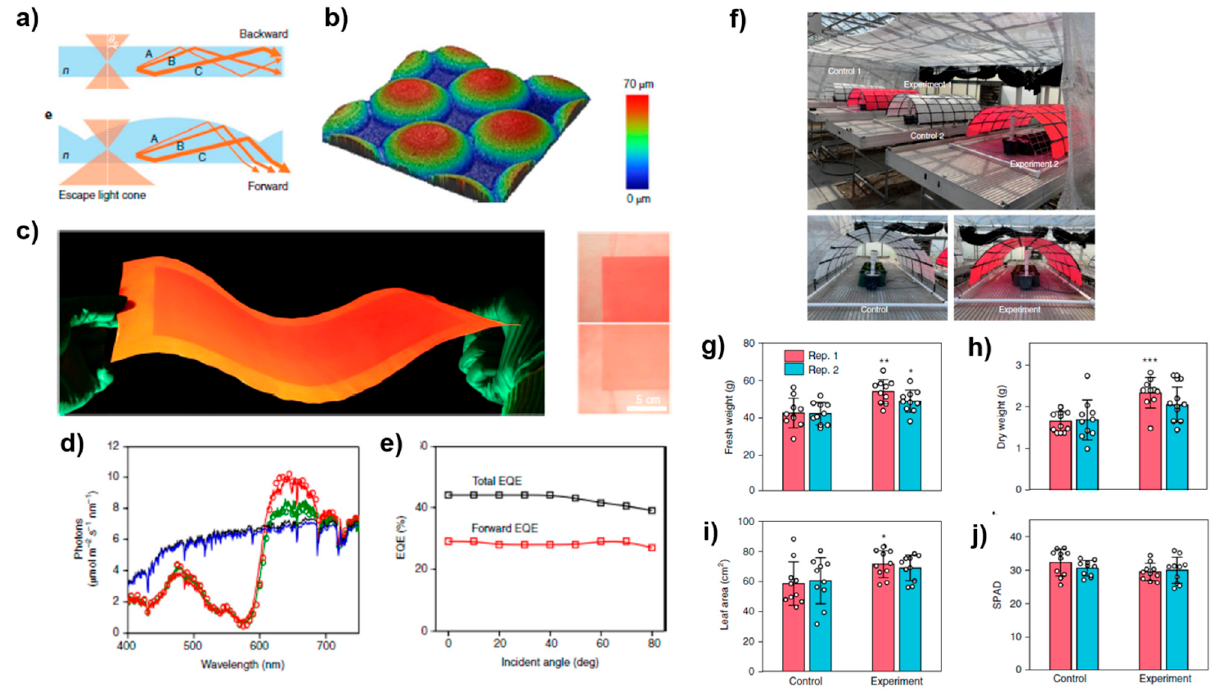
Figure 7. ( a ) Side view of a planar film compared to the unidirectional light-extracting LSC film with surface microdome structures. Thanks to the microstructured surface, rays with incident angles larger than the critical angle can be extracted in the forward direction. ( b ) Surface morphology of the LSC microdome device. ( c ) Photo of the LSC device with a size of 150 mm × 240 mm under green light illumination. ( d ) The forward spectral irradiance of the LSC device with microdomes (red curve), LSC without surface structuring (green curve), planar fluorophore-free film (black curve), and fluorophore-free film with surface structures (blue curve) under the solar irradiance. ( e ) Total external quantum efficiency (EQE) and forward EQE of the LSC device with microdome surface. ( f ) Photograph of the greenhouse facility. Two domes have LSC devices installed (experiment,) while the two others are the control. Data on the growth of the plants under the LSC device compared to the control: fresh weight ( g ) and dry weight ( h ) of the lettuces, and average leaf area ( i ) and soil- plant analysis development (SPAD) values ( j ) of the lettuces after 20 days from transplantation. (* p < 0.05; ** p < 0.01; *** p < 0.001). Reprinted with permission from Ref [69]. Copyright 2021 Springer Nature. Overall, to fabricate an LSC device for CEA applications, the system needs to satisfy the following requirements (Table 2): because each plant has a specific need for certain light wavelengths, the appropriate luminophore must be selected; absorption of light by the luminophore should not excessively reduce PAR; moreover, to compensate for this reduction, ideally, the luminophore should have a high quantum yield. Although thin- film devices present a low cost of fabrication and installation, they should be avoided in favor of more complex architectures that direct as much of the re-emitted light as possible toward the plants. In addition, the waveguide material should be chosen judiciously so that it is compatible with the luminophore but also resistant to weathering, UV, etc.